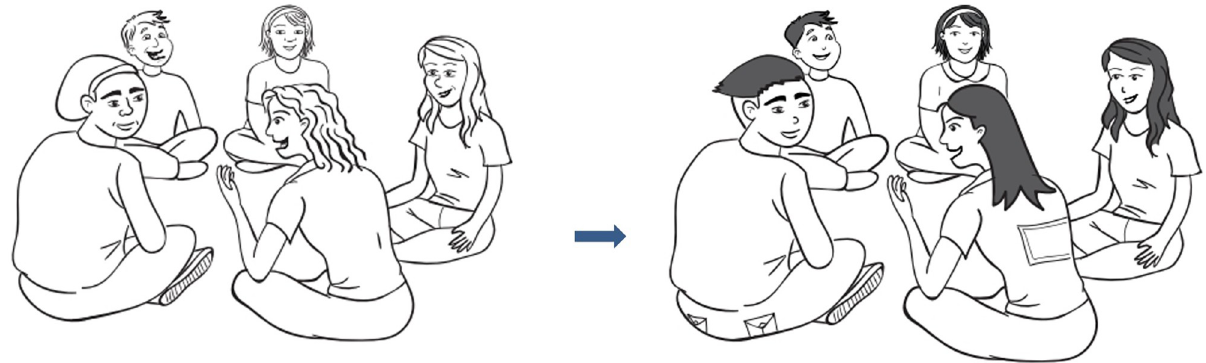
Fig 1. Original and Vietnamese versions of the Group Rule image. Reprinted from the RAP-A and Happy House Participant Workbooks under a CC BY license, with permission from Astrid Wurfl, original copyright 2021.